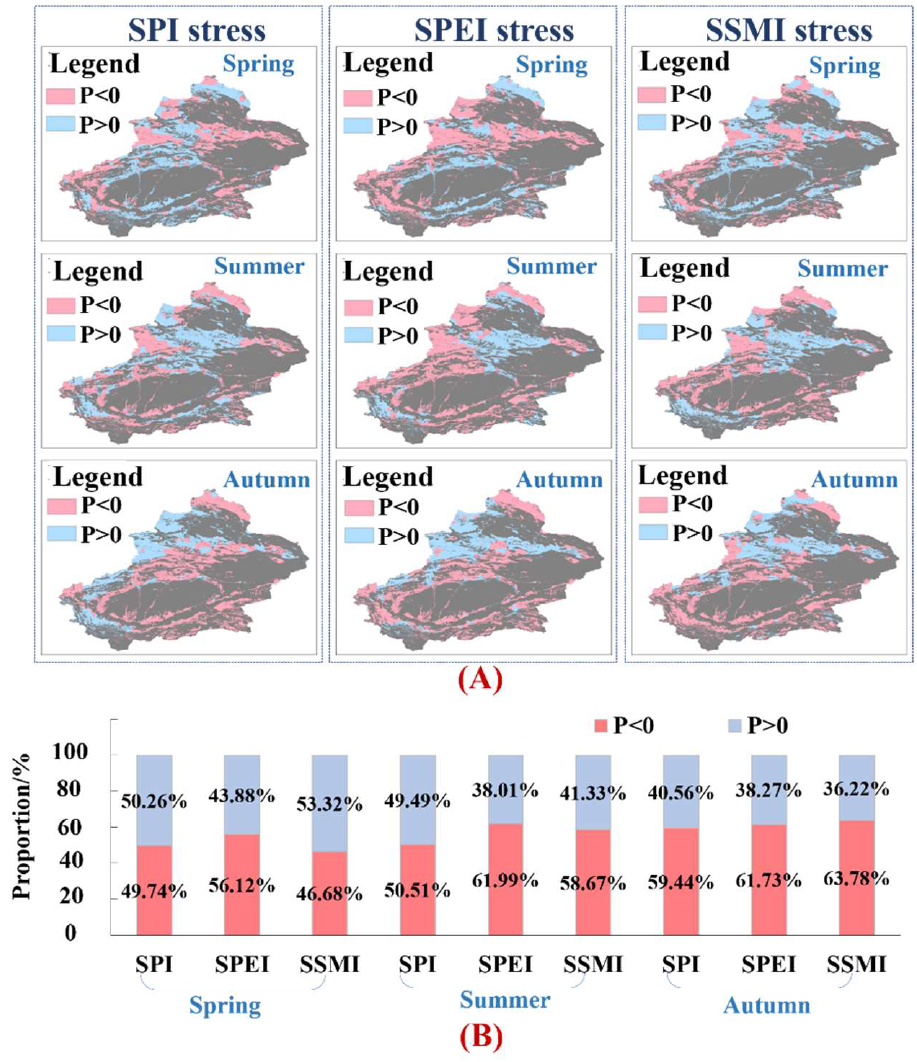
Figure 7. ( A ) The spatial distribution of P (P stage1 –P stage2 ) under extreme drought; ( B ) the regional proportion of P < 0 and P > 0 under extreme drought.